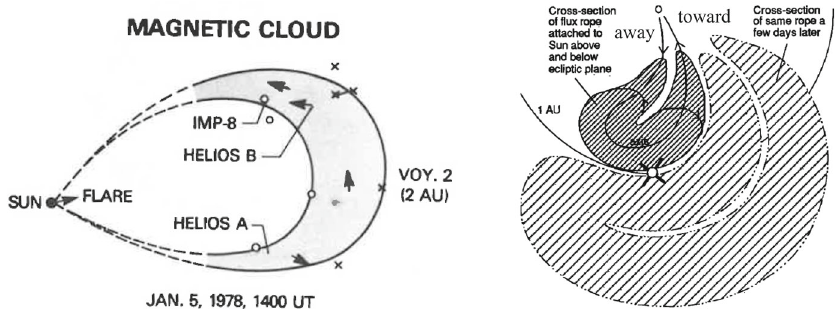
Fig. 8 (Left) The global flux rope axis configuration as deduced from multi-spacecraft observations for a magnetic cloud observed on January 6–8, 1978. All these spacecraft were located close to the ecliptic plane at radial distances between 1–2 AU. (Right) Schematic of a flux rope loop that is distorted along the Parker spiral and carries a sector boundary crossing. Images reproduced by permission from [left] Burlaga et al. (1990); [right] from Crooker et al. (1998), copyright by